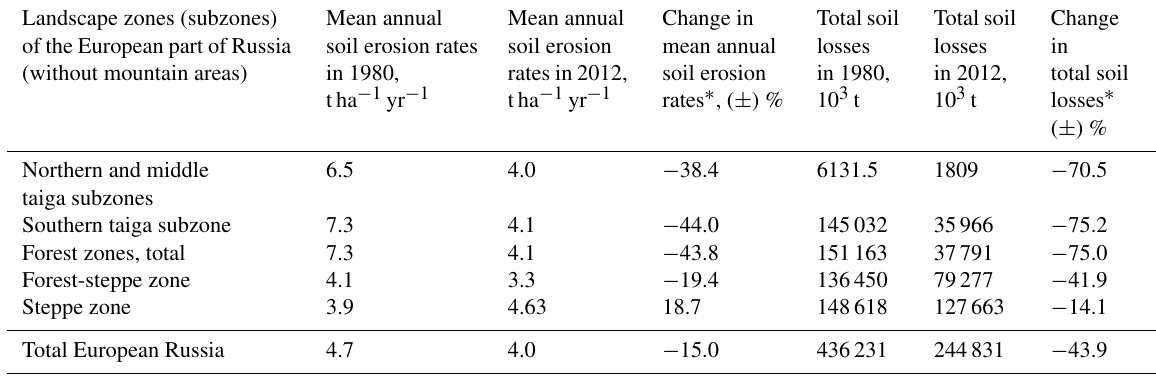
Table 1. Comparison of mean annual soil erosion rates and total soil losses between1980 and 2012. Landscape zones (subzones)